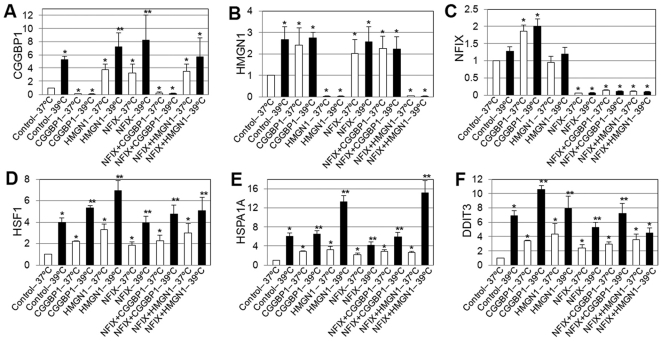
Transcription regulation of heat shock response genes by NFIX, CGGBP1 and HMGN1.CGGBP1 is induced by heat shock alone and depletion of HMGN1 or NFIX at 37°C. This induction by HMGN1 or NFIX depletion is further enhanced at 39°C (A). HMGN1 is induced by heat shock and depletion of CGGBP1 or NFIX at 37°C (B). NFIX is not induced by heat shock or HMGN1 depletion, but only by CGGBP1 depletion at 37°C and 39°C both (C). Bonafide heat shock response genes HSF1 (D), HSPA1A (E) and stress response gene DDIT3 (F) are induced by heat shock and all the siRNA combinations (D, E and F). Single asterisks indicate significant change compared to respective Control-37°C samples. Double asterisks indicate additional significance of change (p<0.05) due to heat shock compared to the respective samples at 37°C. The gene assayed is shown on the Y-axis and the different siRNA-temperature combinations are indicated along the X-axis. All values are average ±S.D. of ratios calculated by delta-delta Ct method using GAPDH as internal control with control-siRNA-37°C values as denominators. As for control-siRNA-37°C the value is this normalized to 1 in each case, no S.D. is shown.